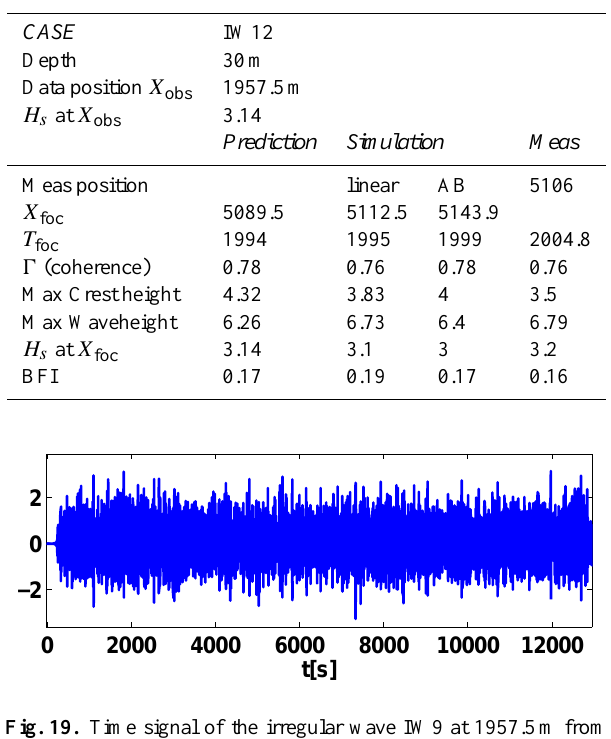
Fig. 19. Time signal of the irregular wave IW9 at 1957.5m from the wave maker.